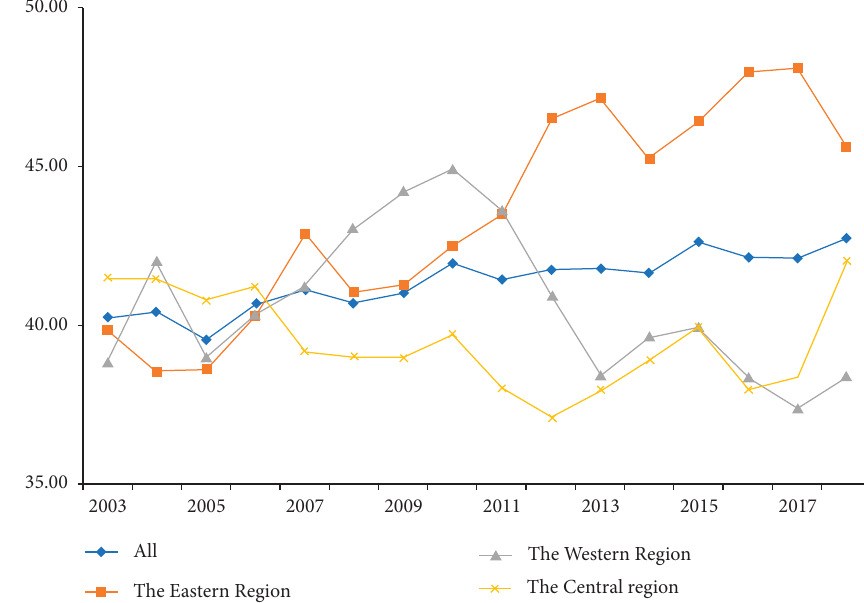
Figure 3: Comparison of efciency loss of construction investmentof diferent regions in China caused by fnancing constraints.